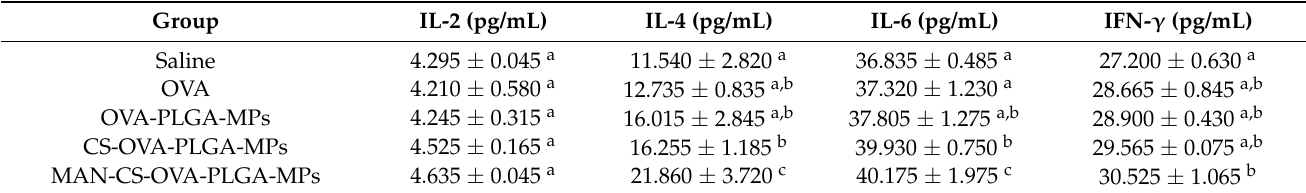
Table 5. Effect of MAN-CS-OVA–PLGA-MPs on the level of several cytokines in the serum of mice.